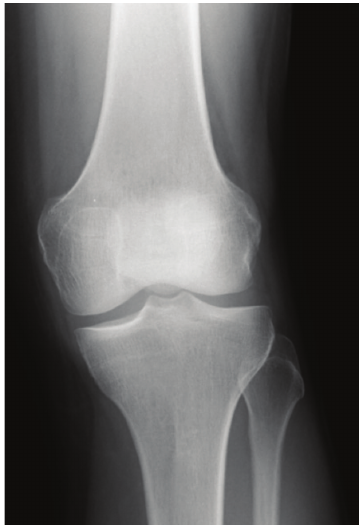
Figure 1: Normal AP radiograph of left knee.